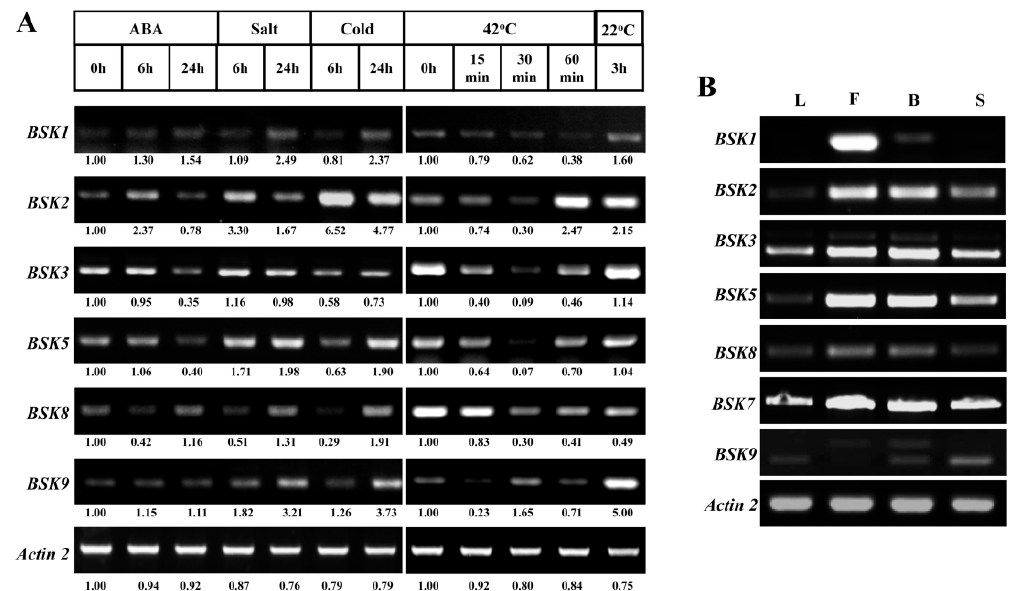
Figure 7. Reverse transcription-polymerase chain reaction (RT-PCR) validation of gene expression patterns of representative BSK genes under stresses and organs. Expression profiles of selected BSK genes under stresses ( A ) and in different tissues ( B ). For various stresses treatment, 7-day-old seedlings were subjected to 10 μ M ABA, 150 mM NaCl and 4 °C on plates, respectively. Heat stress treatment was monitored with four-week-old seedlings under 42 °C for one hour and then recovered at 22 °C for three hours. The intensity corresponding to the individual PCR band was calculated by Image J with reactions from untreated samples as 1.00. L: leaves; F: flowers; B: buds; S: siliques.